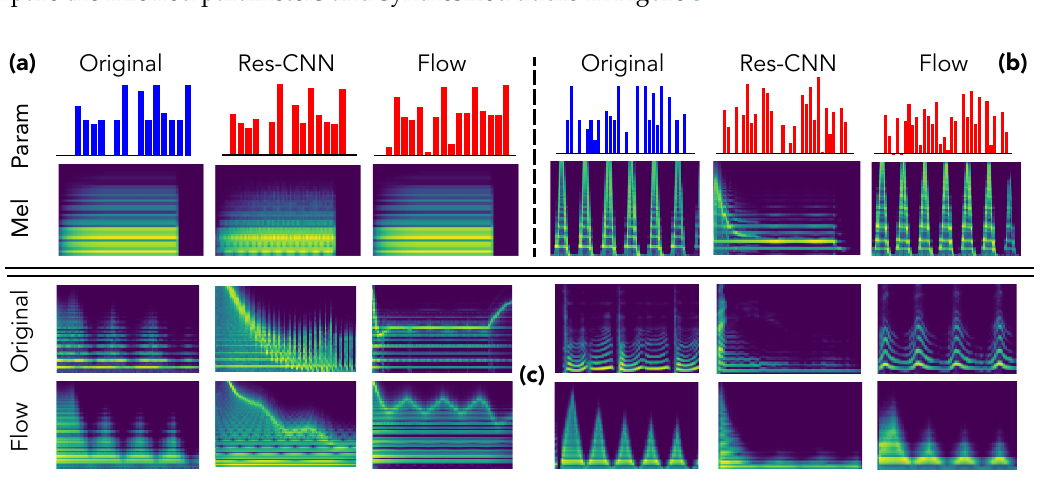
Figure 3. Reconstruction analysis . Comparing parameters inference and resulting audio on the test set with 16 ( a ) or 32 ( b ) parameters, and on the out-of-domain ( c ) sets composed either of sounds from other synthesizers ( left ) or vocal imitations ( right